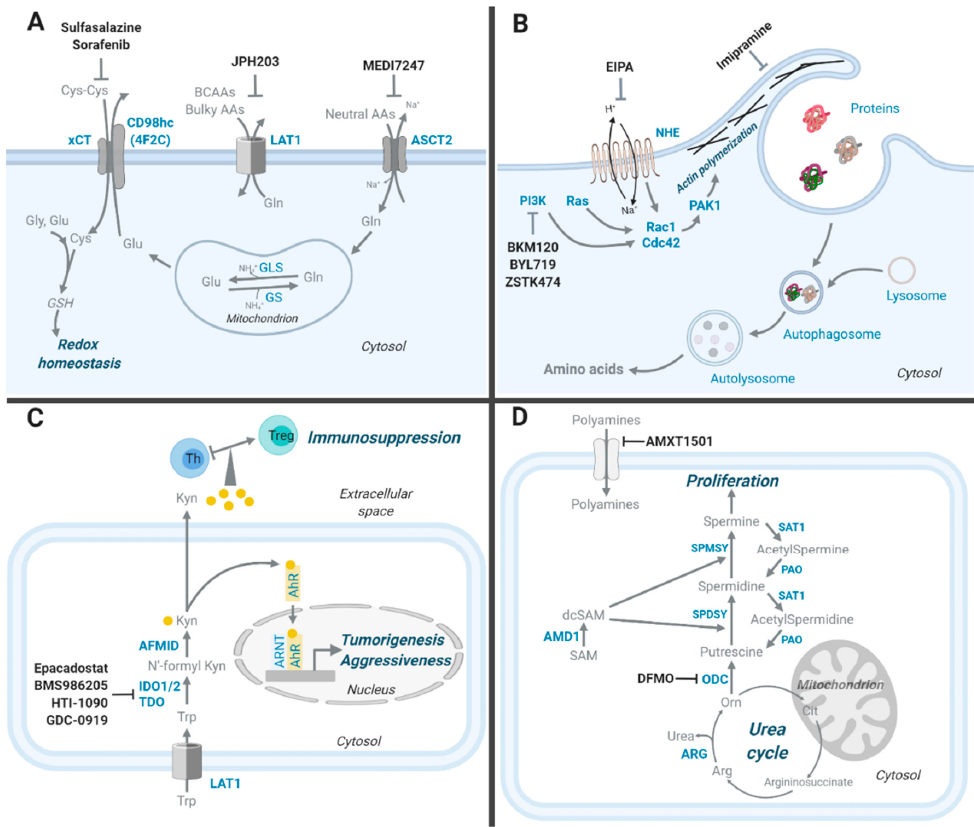
Figure 1. Amino acid metabolic pathways altered in cancer and select inhibitors targeting these pathways. ( A ) Three main amino acid transporters (AATs) upregulated in cancer cells and transporter-targeting inhibitors that are either being used clinically or tested in clinical trials are shown. ( B ) A simplified macropinocytosis process is depicted and inhibitors targeting the process are shown. Rat sarcoma virus oncogene homolog (Ras) and phosphatidylinositol-3-kinases (PI3Ks) positively regulate macropinocytosis by promoting Rac1 and Cdc42-mediated actin polymerization. ( C ) Kynurenine is a catabolite derived from tryptophan. Key enzymes in the kynurenine synthesis pathway, regulatory mechanisms of kynurenine, and IDO/TDO inhibitors tested in clinical trials are shown. ( D ) Polyamines are catabolites derived from arginine. Polyamine synthesis and catabolic pathways are depicted, and polyamine metabolism inhibitors tested in clinical trials are shown. Metabolites are in grey, proteins are in blue, and inhibitors are in black. Proteins: ASCT2: Alanine-serine-cysteine transporters 2; LAT1: L-type amino acid transporter 1; xCT/CD98hc: 4FC2 cystine/glutamate heterodimeric antiporter; GLS: Glutaminase; GS: Glutamine synthetase; NHE: Na + /H + exchanger; Rac1: Ras-related C3 botulinum toxin substrate 1; Cdc42: Cell division control protein 42; PAK1: P21-activate kinase 1; PI3K: Phosphoinositide 3-kinases; IDO1/2: Indoleamine-2,3-dioxygenase 1,2; TDO: Tryptophan-2,3-dioxygenase; AFMID: Kynurenine formamidase; AhR: Aryl